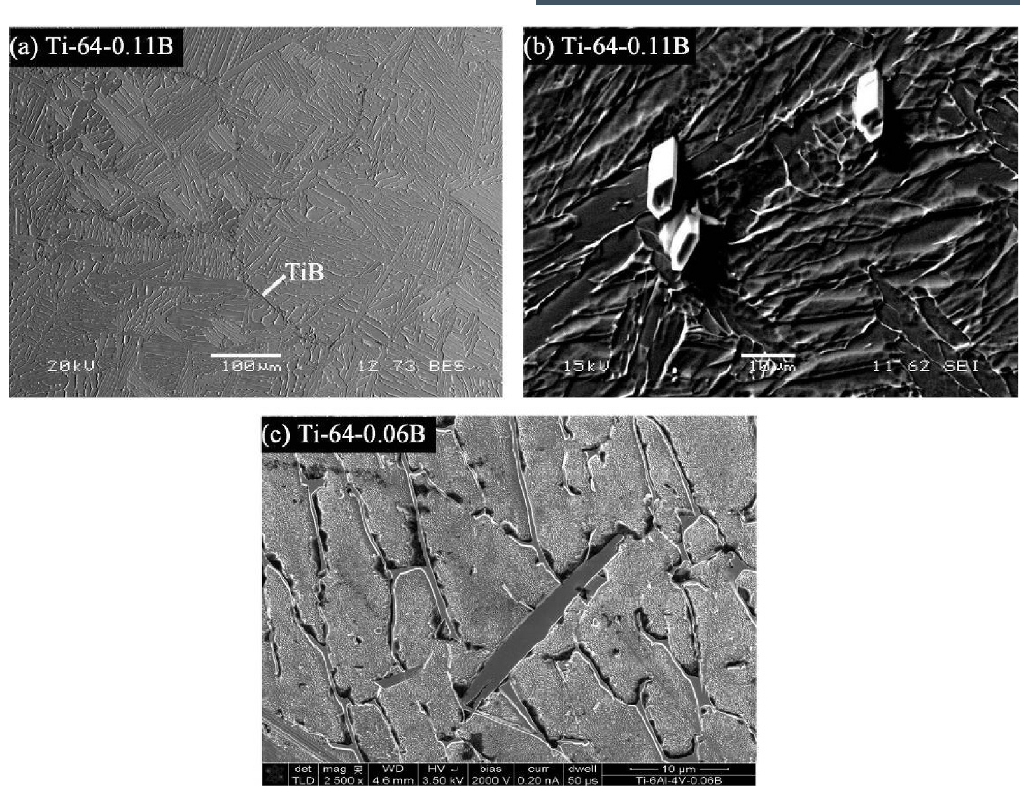
Figure 4. SEM micrographs showing the location and morphology of TiB precipitates in boron modified Ti-64 alloys. Micrograph (a) shows the TiB particles along prior beta grain boundaries, (b) shows a cross section of TiB needles, and (c) shows a TiB particle lying within a prior β grain crossing several individual alpha laths.